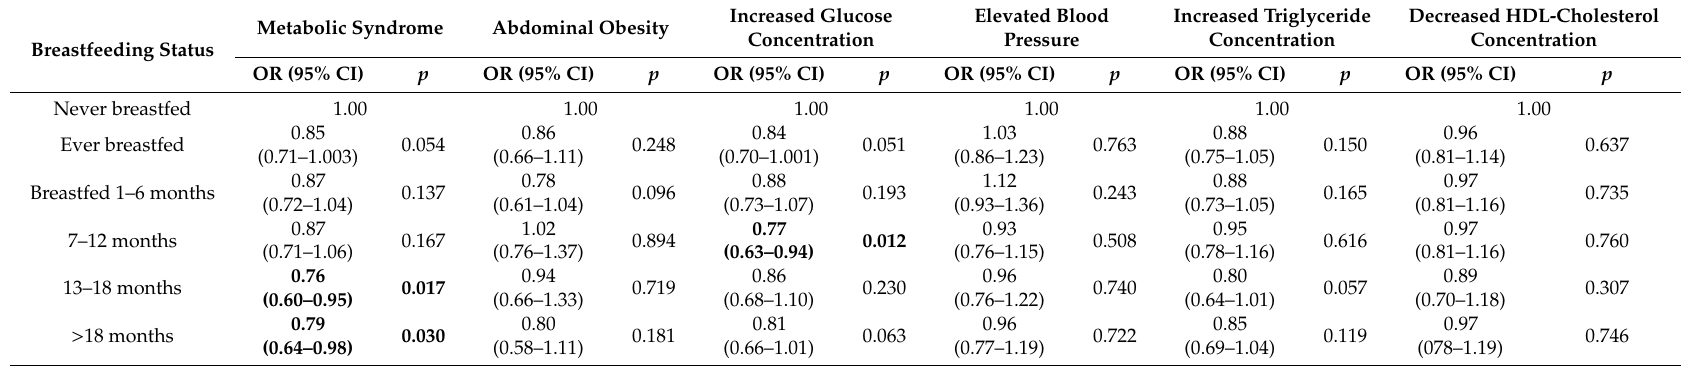
Table 2. Multivariable logistic regression analysis for metabolic syndrome (MetS) and its components in relation to breastfeeding duration (adjusted for age, BMI, education, place of living, marital status, parity, menopausal status, hormone therapy, physical activity, sitting time, traditional, healthy, westernized dietary patterns,